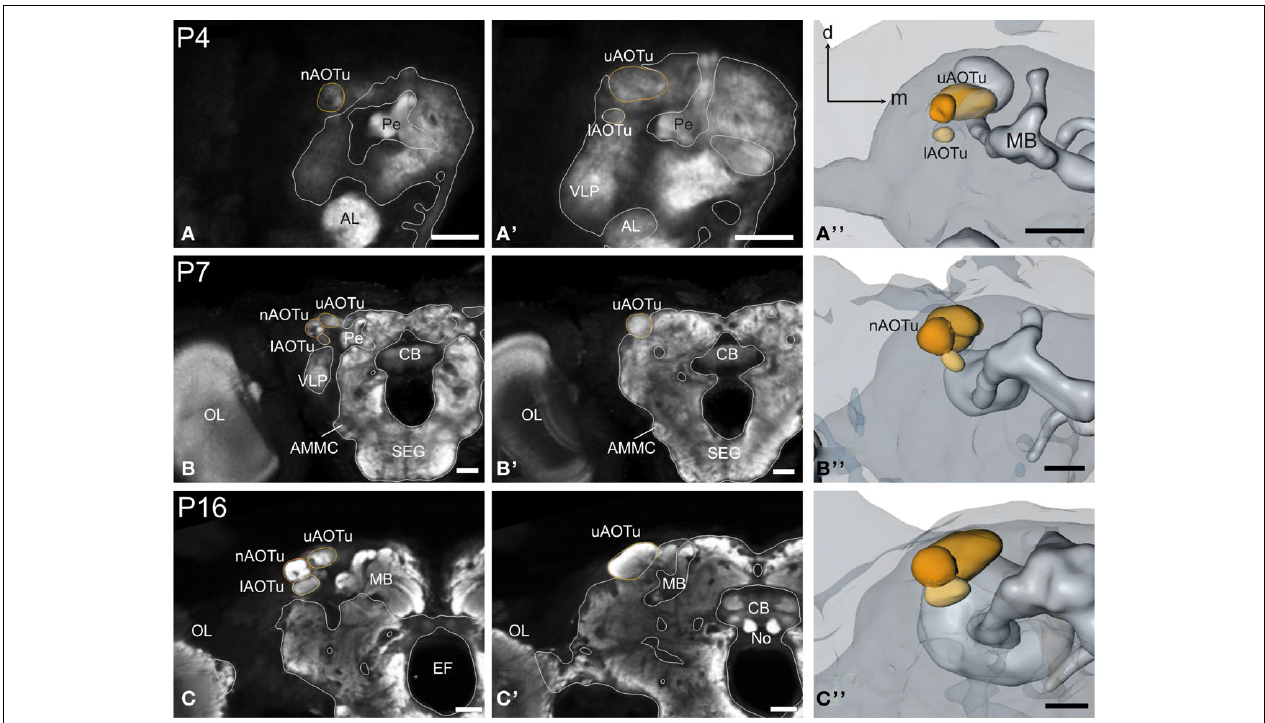
(B–B ′′ ) Stage P7: independent of the rotation events of mushroom bodies (MBs) and the central complex, the subunits of the AOTu stay in their position and increased in size. (C–C ′′ ) Stage 16: all subunits of the AOTu increased further in size. The uAOTu remains the largest subunit throughout metamorphic development. Orientation bars: d, dorsal; m, medial; all scale bars: 100